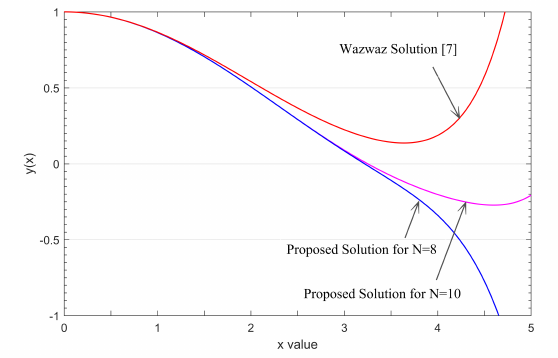
Fig. 7: Plot of obtained solution y(x) for N = 8, N = 10 and series solution presented by Wazwaz [7] for example